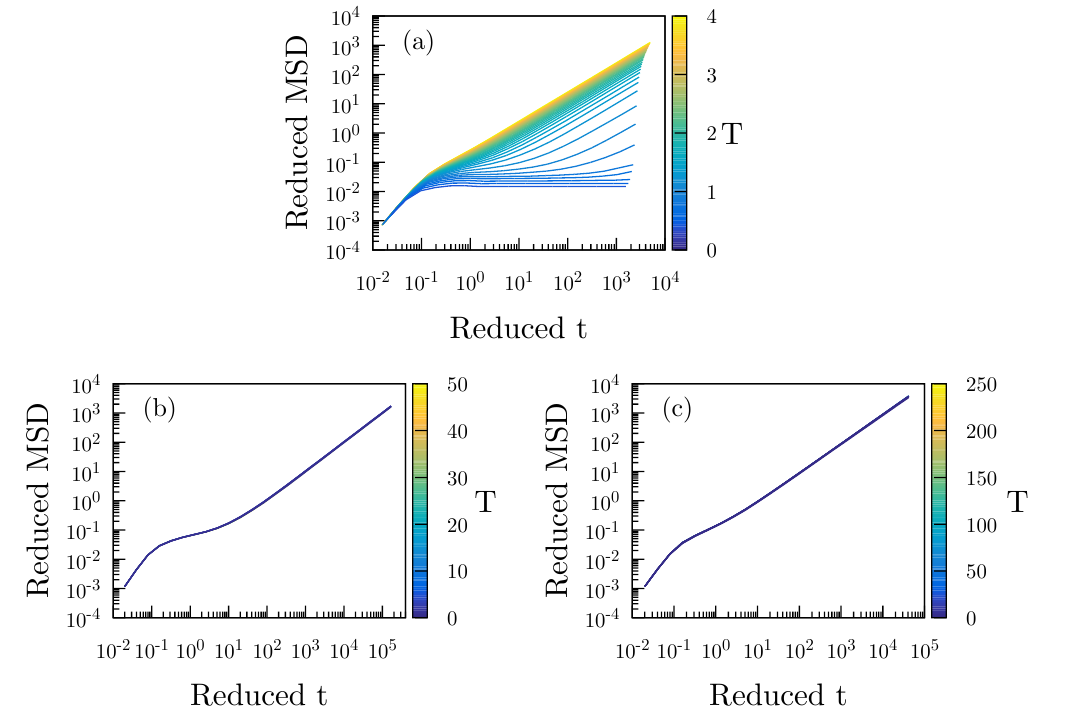
Figure 3. A particle mean-square displacement in reduced units of three different sets of simulations of the Wahnström binary LJ mixture [46]. ( a ) gives MSD data along the ρ = 0.85 isochore (where density is given in AA particle units). ( b ) is for the isomorph with reference state point ( ρ , T ) = ( 0.85,1.2 ) . ( c ) is for the isomorph with reference state point ( ρ , T ) = ( 0.85,2.0 )